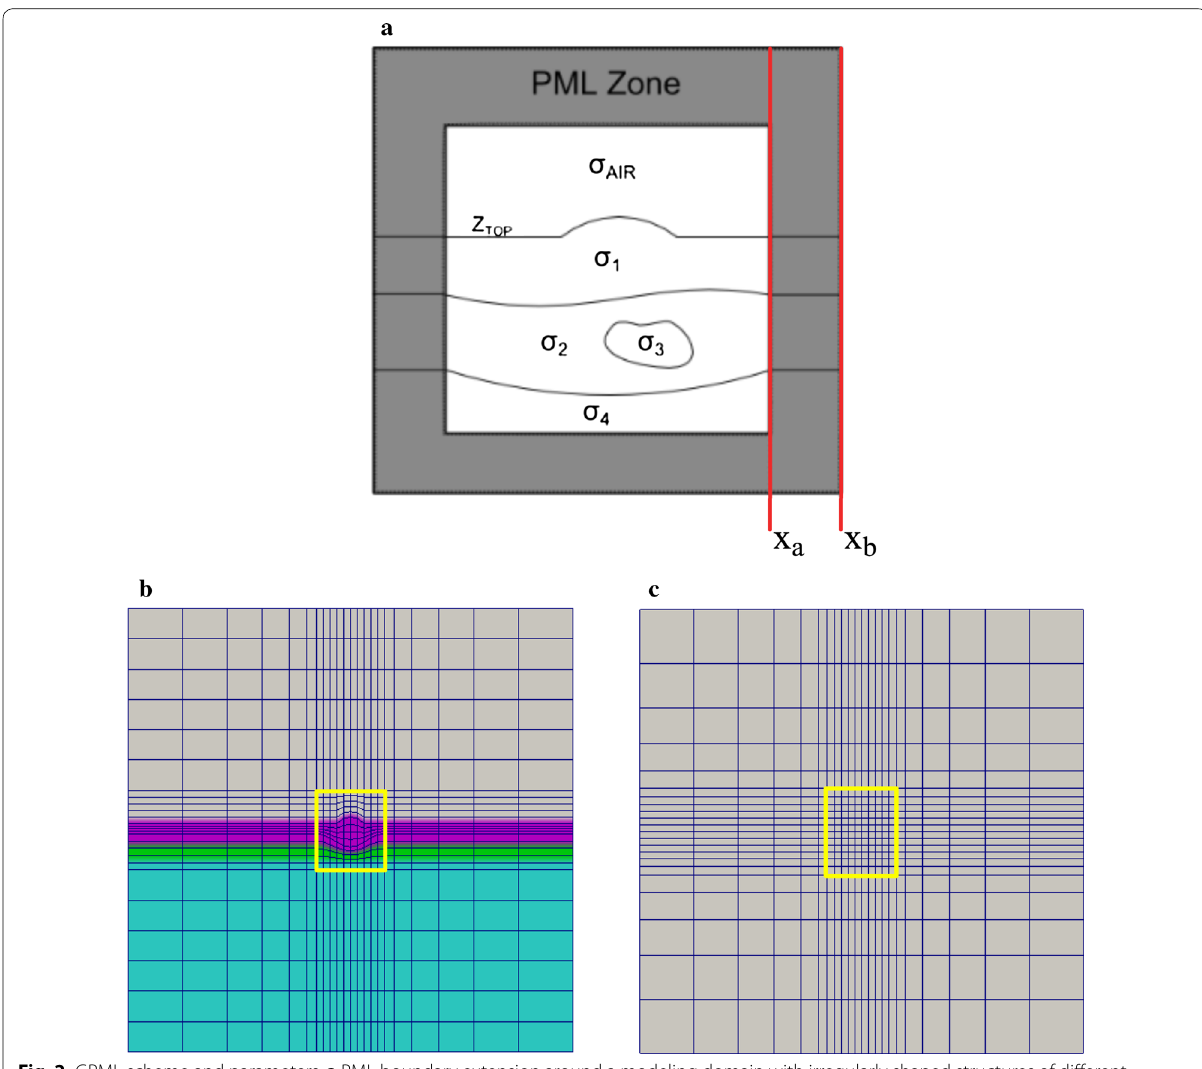
Fig. 2 GPML scheme and parameters. a PML boundary extension around a modeling domain with irregularly shaped structures of different conductivity values σ i . PML zone starts at x a and ends at the point x b which are indicated for one of ˆ x direction (marked by red lines). b Vertical cross‑section through the computational domain of the respective structure, including the PML zone. The numerical grid contains irregularities of the model structure and is regular within the PML zone. c Horizontal cross‑section through the computational grid structure. The numerical grid is regularly spaced within the model domain and non‑regularly extended in the PML zone. The model domain is marked by the yellow rectangle in